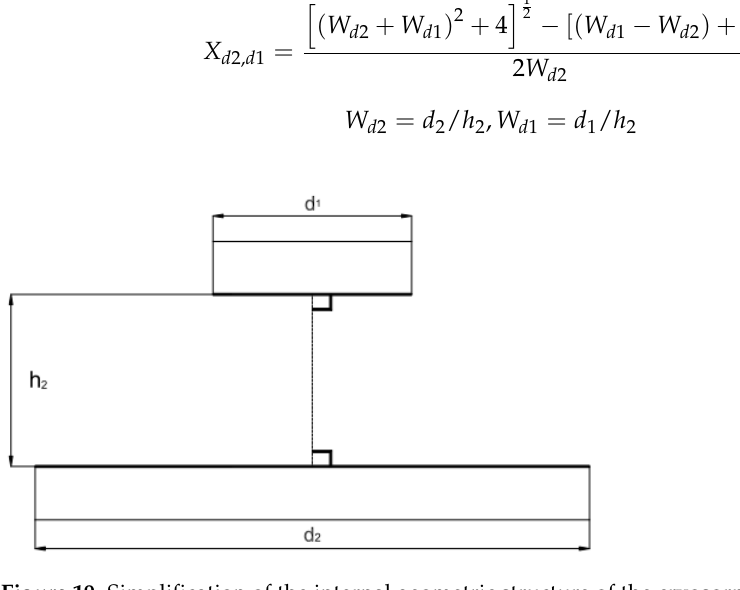
Figure 19. Simplification of the internal geometric structure of the cryosorption pumps.